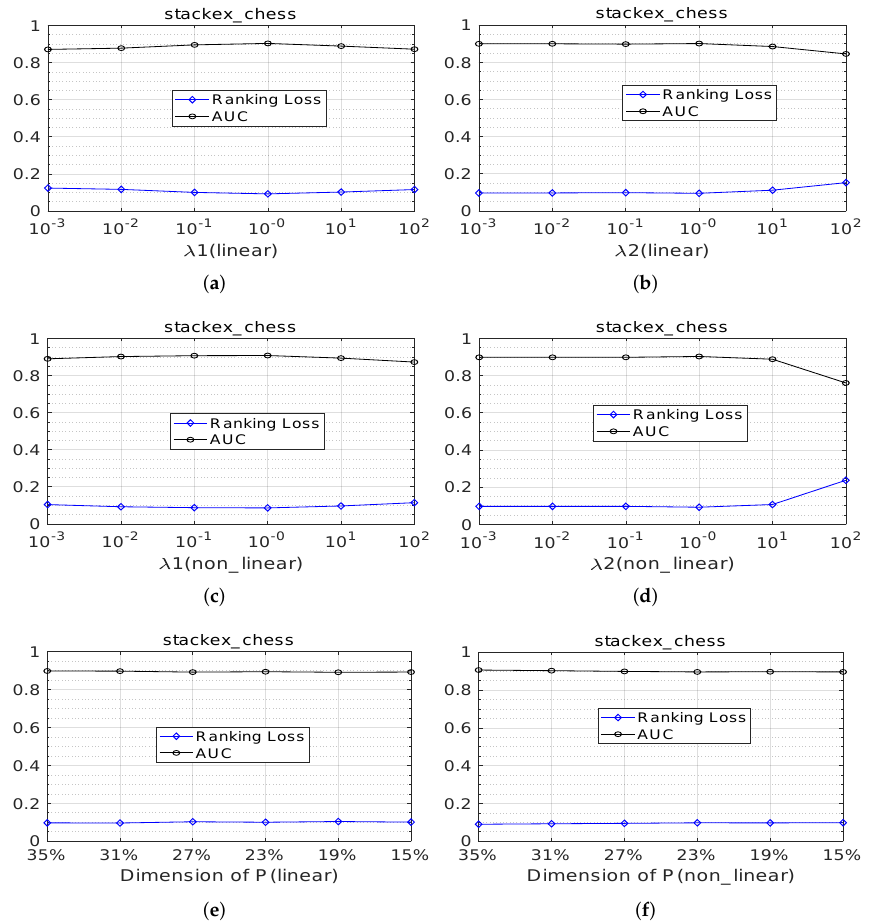
Figure 2. Parameter analysis of MLLCE and NL-MLLCE over Stackex-chess data sets. For AUC (Ranking Loss ), the bigger (smaller) the value, the better the performance of a classifier. ( a ) Result of MLLCE with different values of λ 1 . ( b ) Result of MLLCE with different values of λ 2 . ( c ) Result of NL-MLLCE with different values of λ 1 . ( d ) Result of NL-MLLCE with different values of λ 2 . ( e ) Result of MLLCE with different values of p . ( f ) Result of NL-MLLCE with different values of p